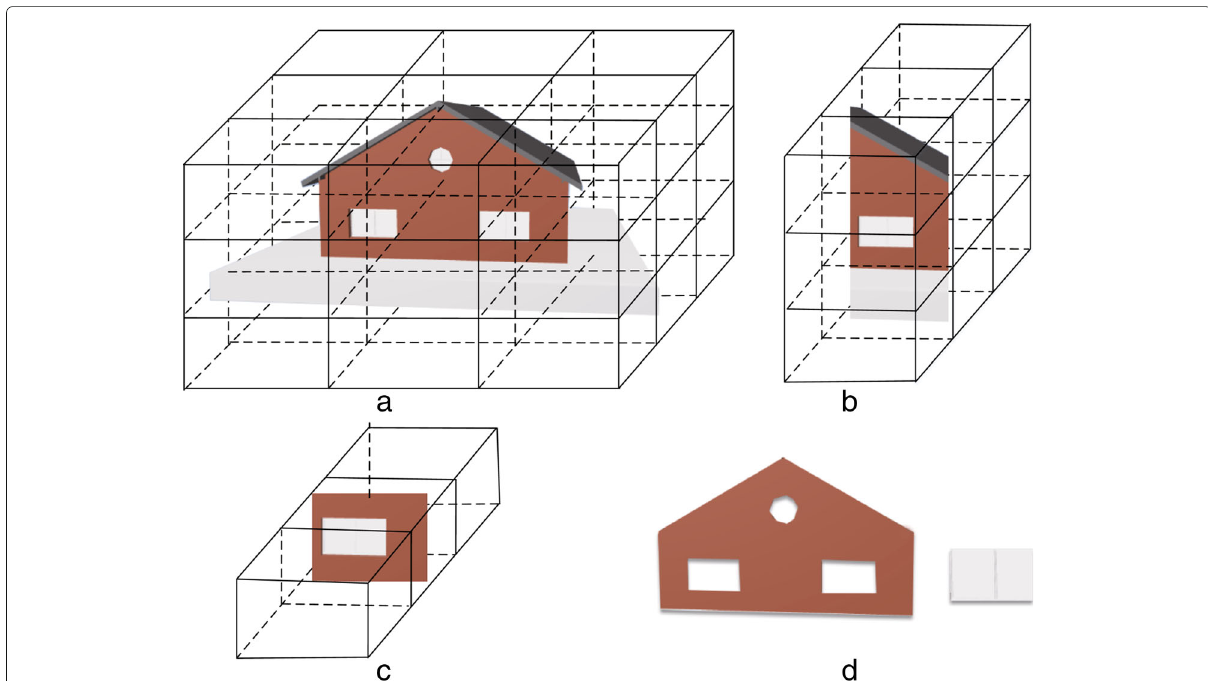
Fig. 3 Extracting external components based on node classification. The external doors and windows are extracted accurately. a Bounding box division b Choose a random column c Traversal from near to far d Get component